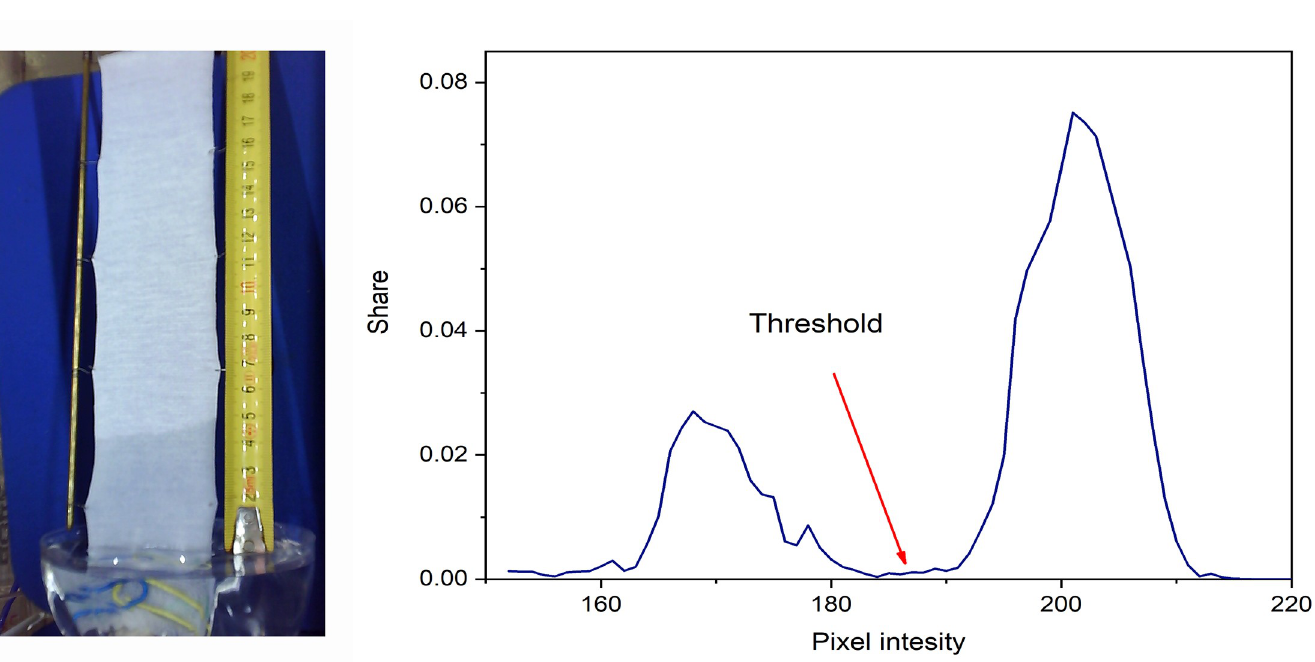
Fig 7. Example of the a) recorded image, and b) histogram of the processed image section during determination of wicking.